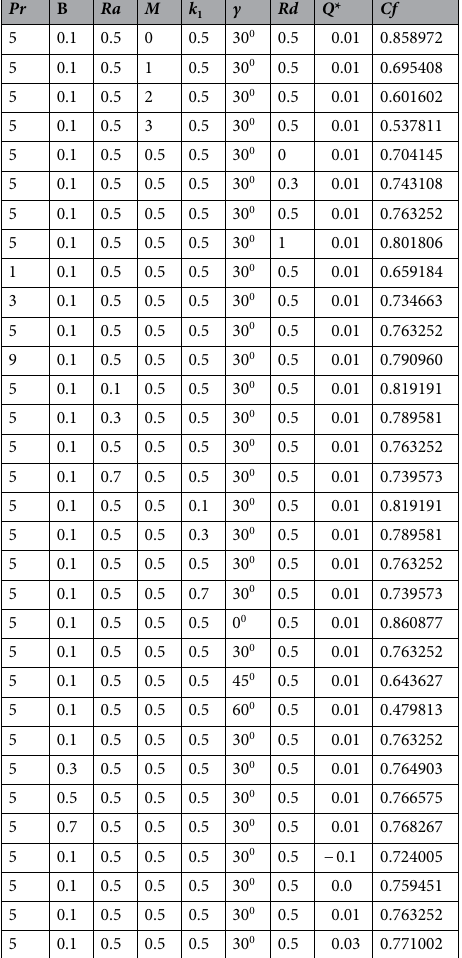
Table 2. Skin friction variation for various parameters values.